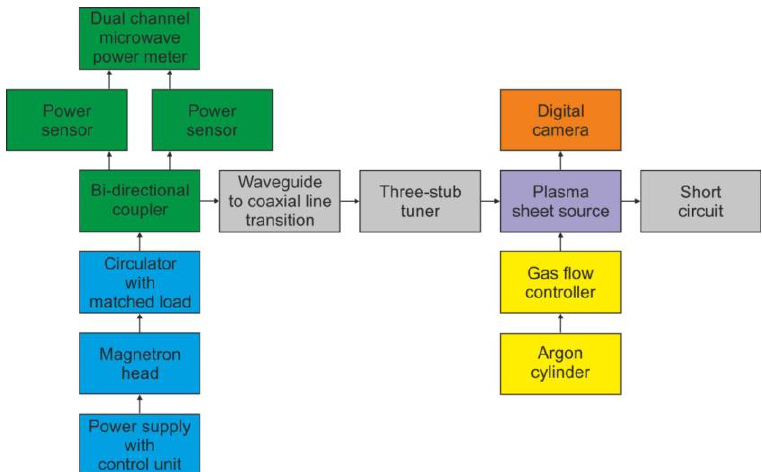
Figure 19. Schematic diagram of the experimental arrangement with the atmospheric pressure microwave argon plasma sheet source. microwave argon plasma sheet